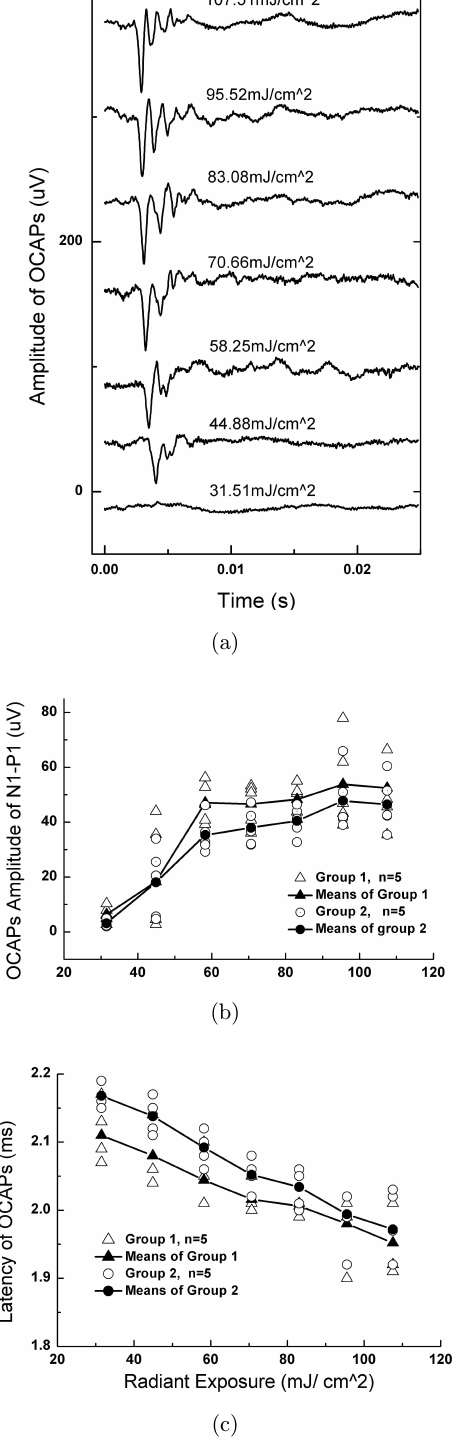
Fig. 5. (a) Optical stimulated CAPs obtained upon increasing the radiant exposure at the end of the optical ¯ber from 31.51 mJ/cm 2 to 107.51 mJ/cm 2 . (b, c) The amplitudes of N 1 – P 1 and latency of N 1 for all animals in two groups are plotted as hollow triangles and hollow circles, respectively. Solid triangles and circles stand for their respective means.